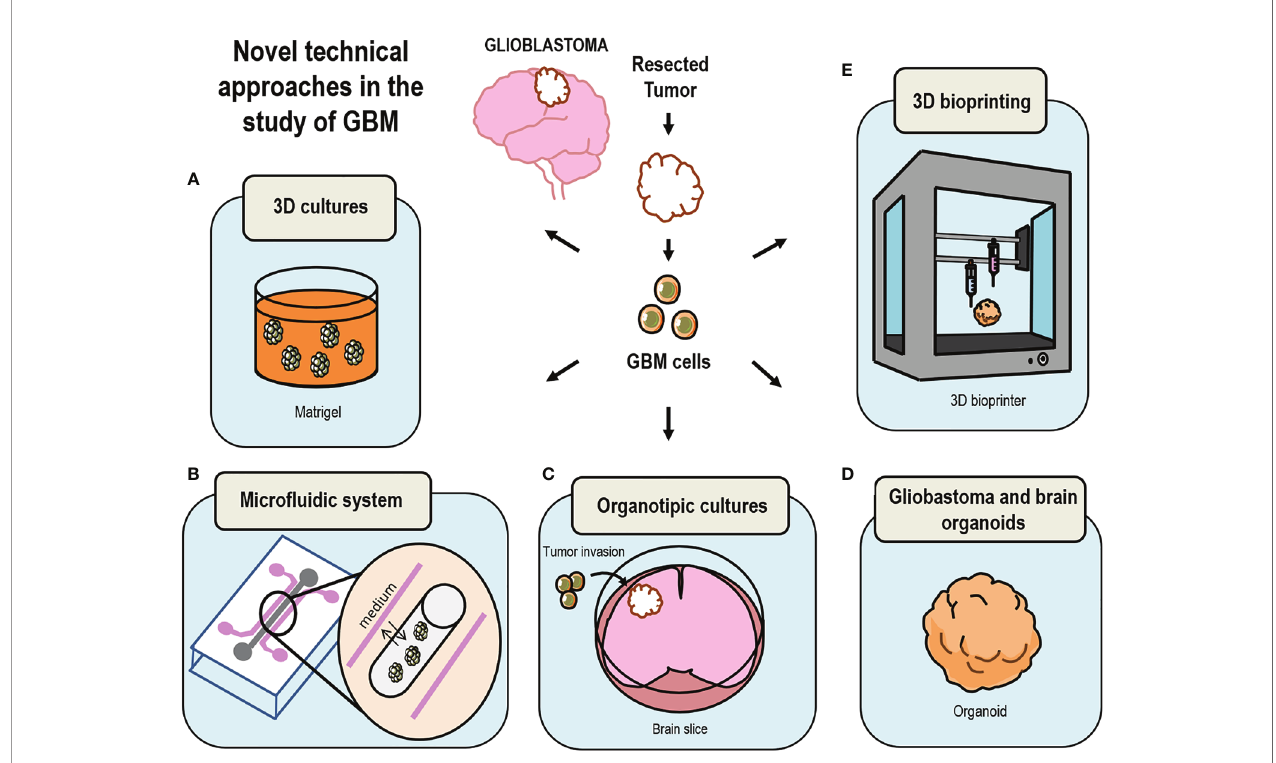
FIGURE 2 | Drawing summary of novel models currently in use to study GBM. (A) 3D Cultures of cells embedded in Matrigel have been key techniques in the development of brain organoids; (B) growth of 3D structures using micro fl uidic systems replicates the changing microenvironment surrounding GBM in the human brain; (C) GBM cells can be grafted in vitro in human brain slices grown as organotypic cultures replicating the natural environment of a GBM tumor; (D) culture GBM organoids by either using glioma cells or by inserting GSC into brain organoids; (E) bio-print GBM 3D-spheroids using extracellular matrix materials and other cell